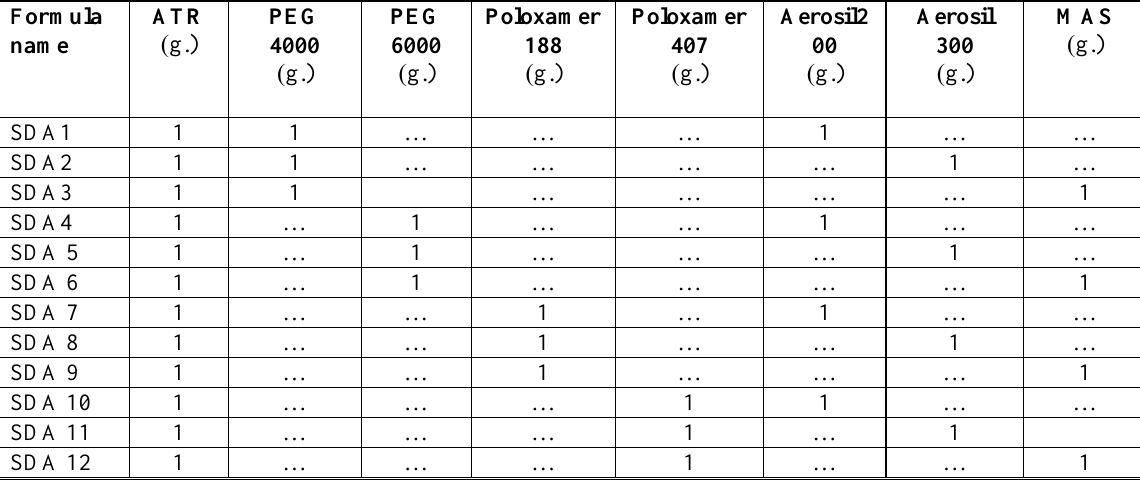
Table 2.Composition of different SDA formulas of ATR.